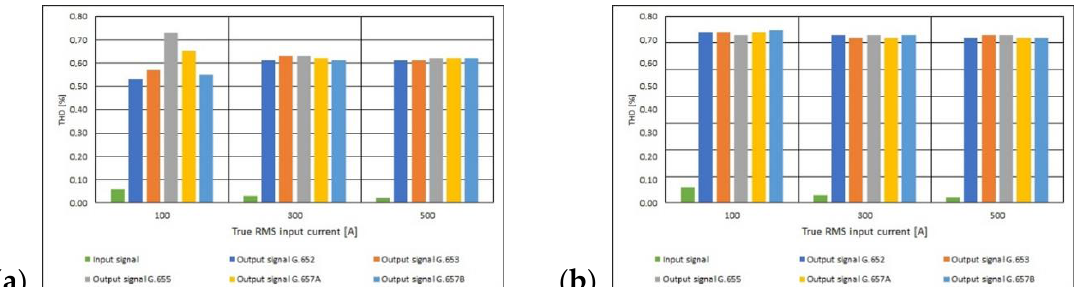
Figure 10. Values of THD for polarimetric current sensor with measuring coil made of the different standards of single mode telecommunications fibers [own results]: ( a ) for 40-turns measuring coil and ( b ) for 80-turns measuring coil.